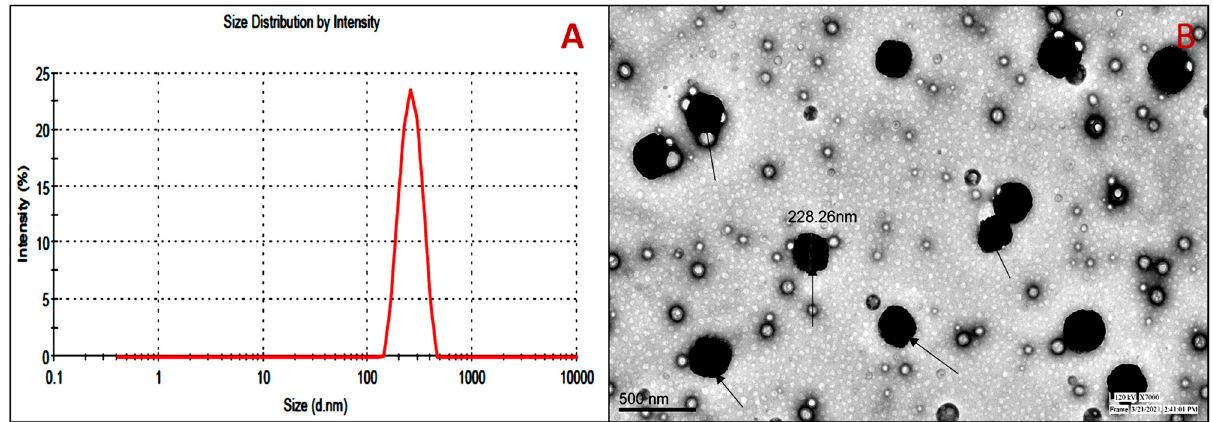
Figure 3. Vesicle size ( A ), and ( B ) TEM image of optimized diclofenac bilosomes (DC-BMs-opt marked with arrow).